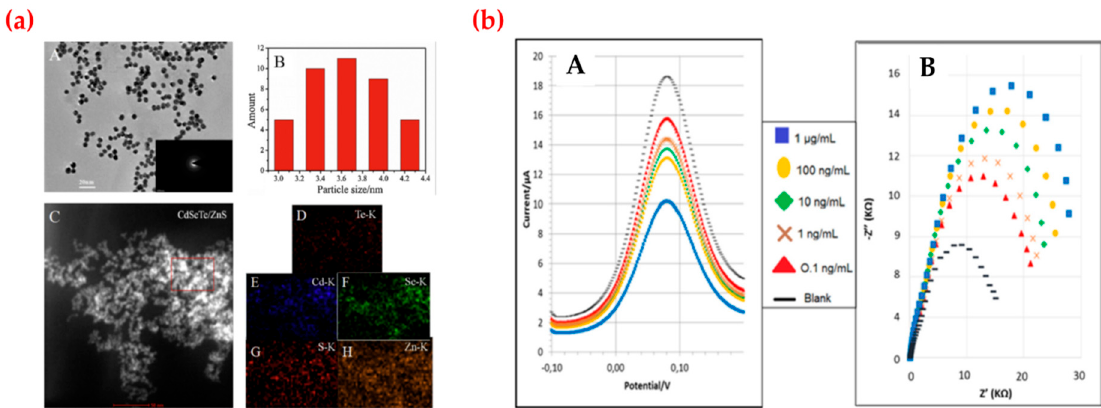
Figure 8. ( a ) Diagram for fabrication of the sensor and ( b ) differential pulse voltammograms (A) and Nyquist plots of creatinine solutions (B). Republished with permission from [118,119]; permission conveyed through the Copyright Clearance Center, Inc.